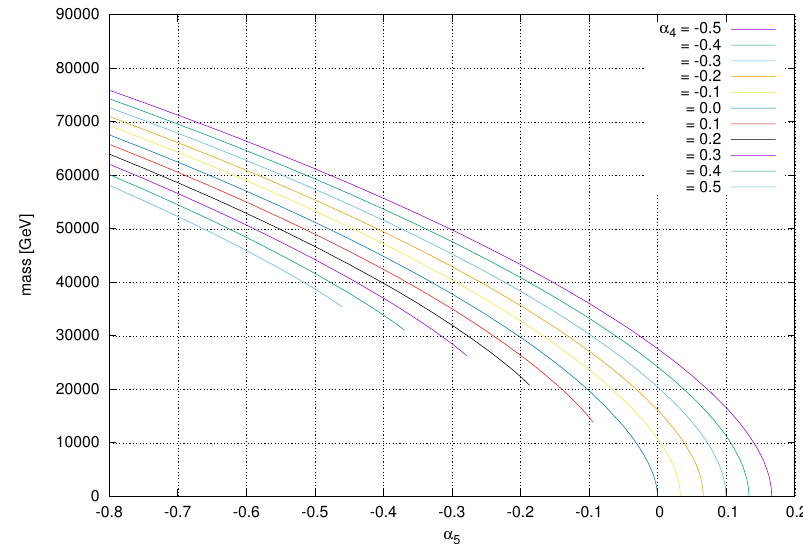
Figure 2 . Mass of the EW-Skyrmion as functions of (cid:11) 5 for various choices of (cid:11) 4 . Kinetic part of the Lagrangian and the Higgs potential are taken to be the SM forms (eqs. (2.4),